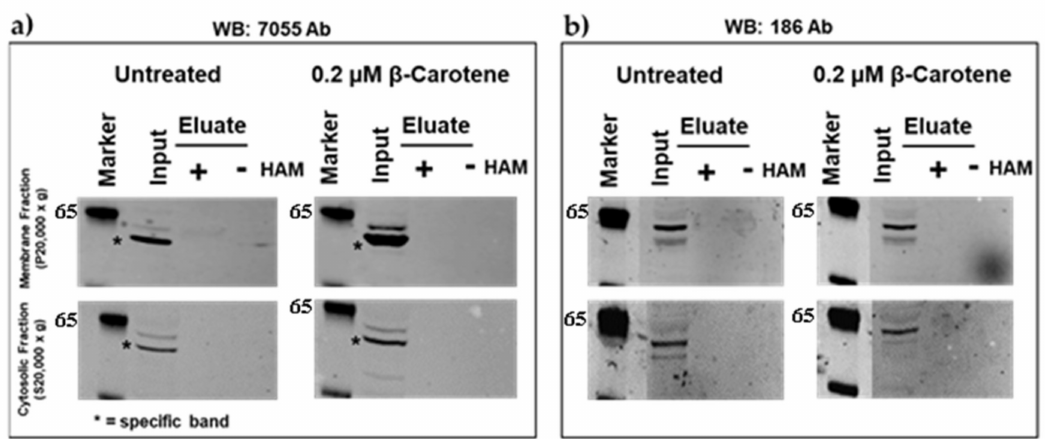
Figure 3. Detection of recombinant mouse C111S BCO2 / V5 / Lumio protein palmitoylation by acyl-RAC assays. Analysis of palmitoylation of mBCO2 from HEK293F-expressed lysates treated with 0.2 µ M β -carotene in 0.01% OTG or 0.01% OTG vehicle control was performed by acyl-RAC assays. Top panel demonstrates results for membrane proteins recovered from 20,000 × g pellet and bottom panel demonstrates results for cytosolic proteins fraction (20,000 × g supernatant). Results are representative of three independent experiments (raw data are submitted in Supplementary Materials. ( a ) The presence of mutant mBCO2 was probed by immunoblotting with rabbit polyclonal anti-human BCO2 (7055); ( b ) The presence of mutant mBCO2 was probed by immunoblotting with rabbit polyclonal anti-mouse BCO2 (186).